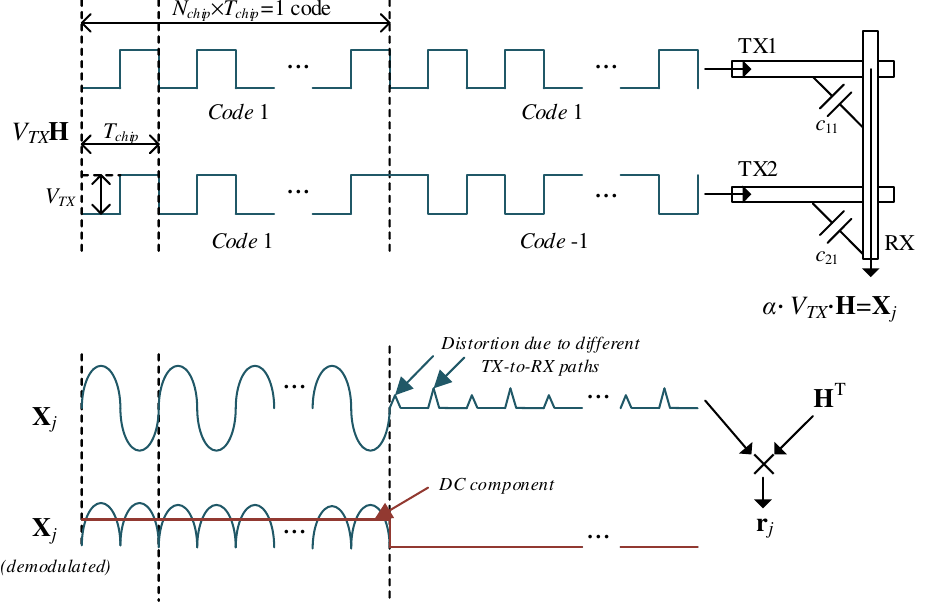
Figure 1. Example of two-channel simultaneous driving and